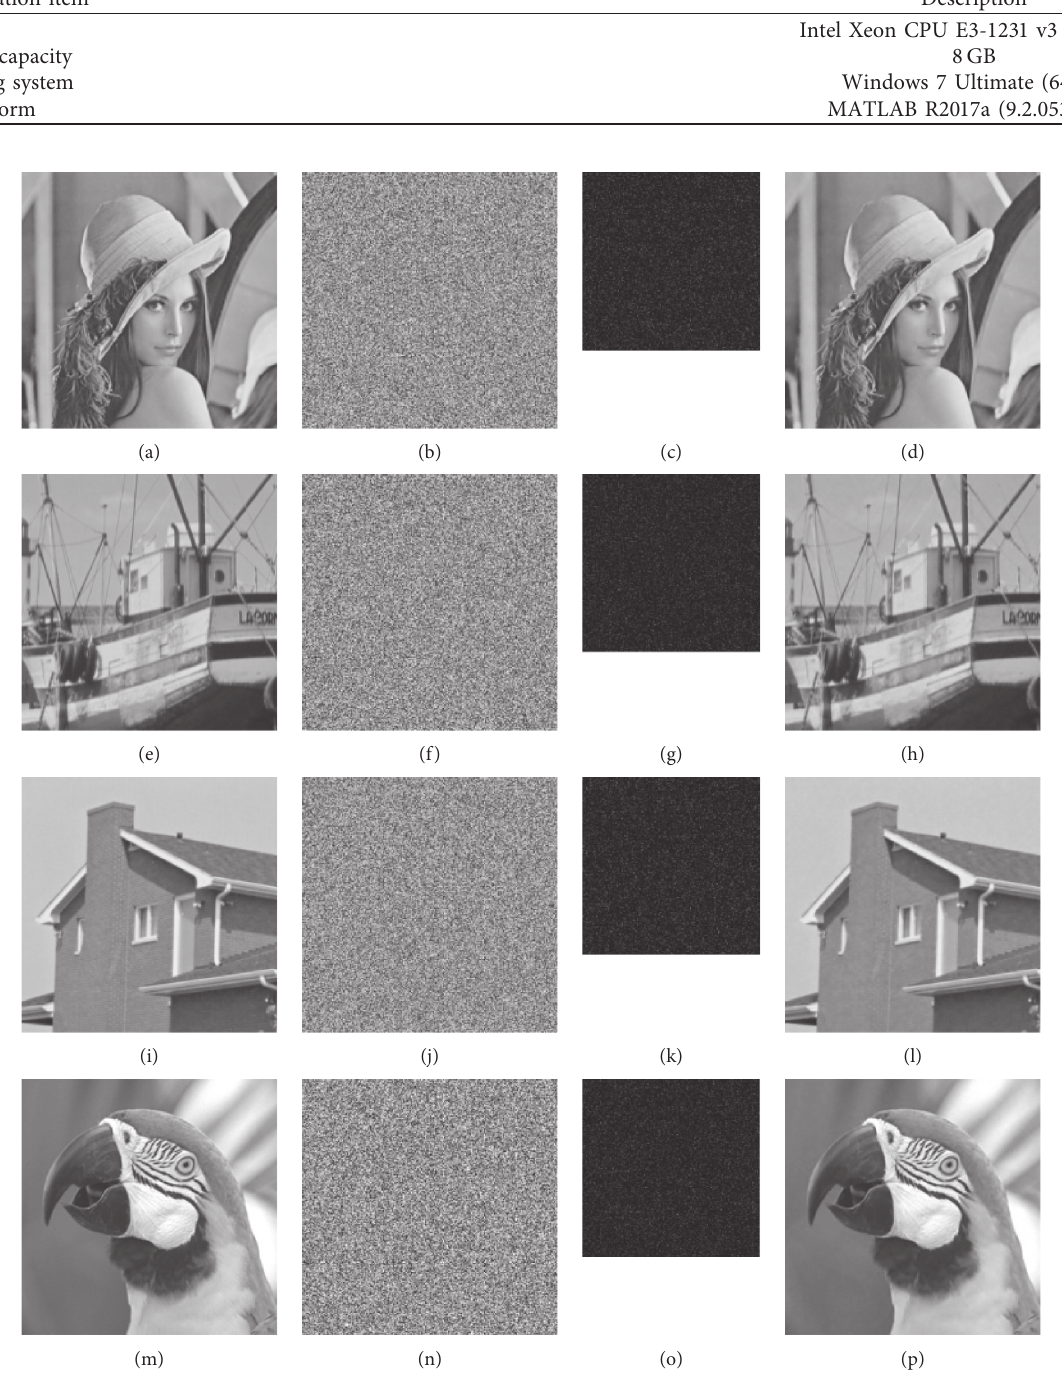
Figure 6: Encryption and reconstruction of four plain images: (a) plain image Lena; (b) cipher image of (a); (c) compressed cipher image of (a); (d) reconstructed image of (c); (e) plain image of Boats; (f) cipher image of (e); (g) compressed cipher image of (e); (h) reconstructed image of (g); (i) plain image of House; (j) cipher image of (i); (k) compressed cipher image of (i); (l) reconstructed image of (k); (m) plain image of Parrots; (n) cipher image of (m); (o) compressed cipher image of (m); (p) reconstructed image of